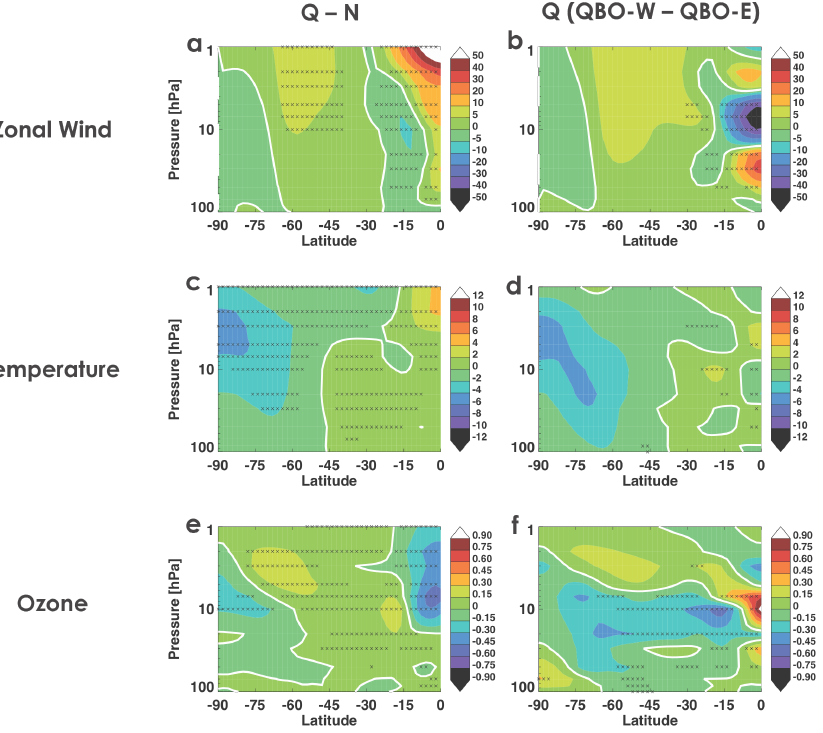
Figure 10 : September (a–b) zonal wind [m s -1 ], (c–d) temperature [K] and (e–f) ozone [ppmv] differences in the Southern Hemisphere. (a, c, e) Q – N mean differences; (b, d, f) QBO–westerly – QBO–easterly differences in the Q simulation. White contours indicate zero difference. Black Xs indicate differences significant at the 95% level in a two–tailed t–test.